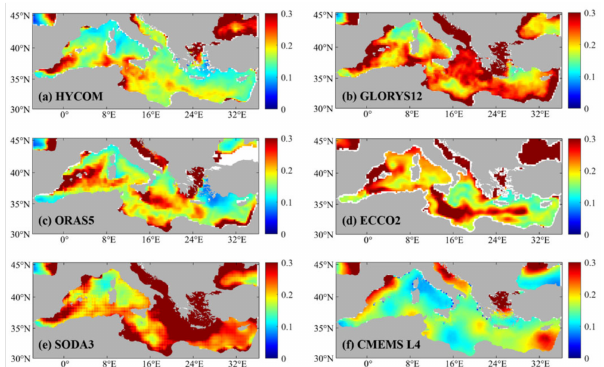
Figure 2. Mean SSS field in the Mediterranean Sea averaged from ( a ) HYCOM reanalysis, ( b ) GLORYS12, ( c ) ORAS5, ( d ) ECCO2, ( e ) SODA 3.11.2 and ( f ) CMEMS L4 SSS on a consistent 0.25 ◦ × 0.25 ◦ grid. The unit is in PSU.